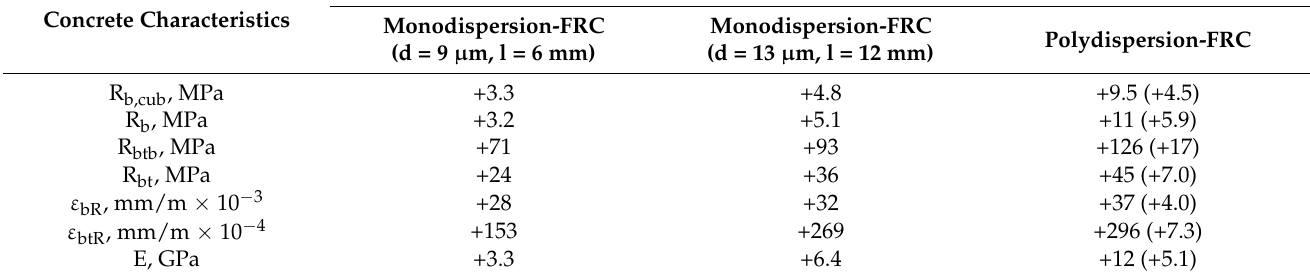
Table 9. Increases in strength and deformation characteristics of fiber-reinforced concrete specimens depending on the type of dispersed